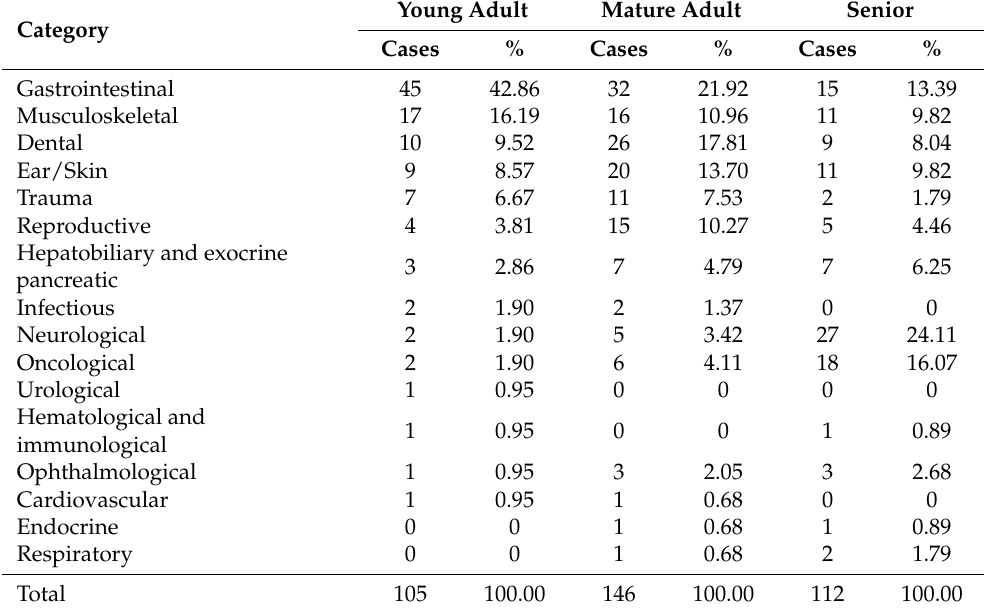
Table 4. Disease categories by age group.